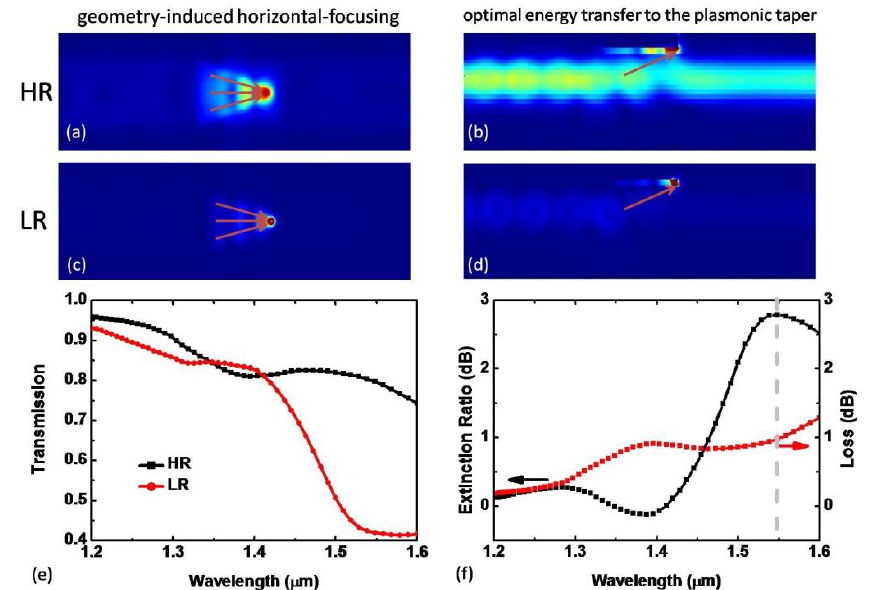
Figure 3. ( a ) Geometry-induced horizontal focusing and ( b ) optimal energy transfer to the taper of the plasmonic memristor at HR state; enhanced plasmon–filament interaction in the plasmonic memristor at LR state due to ( c ) geometry-induced horizontal focusing and ( d ) optimal energy transfer; ( e ) optical transmission of the plasmonic memristor at HR and LR state; ( f ) extinction ration (ER) and insertion loss of the plasmonic memristor. Table 1. Summary of the performances of some reported plasmonic memristors.